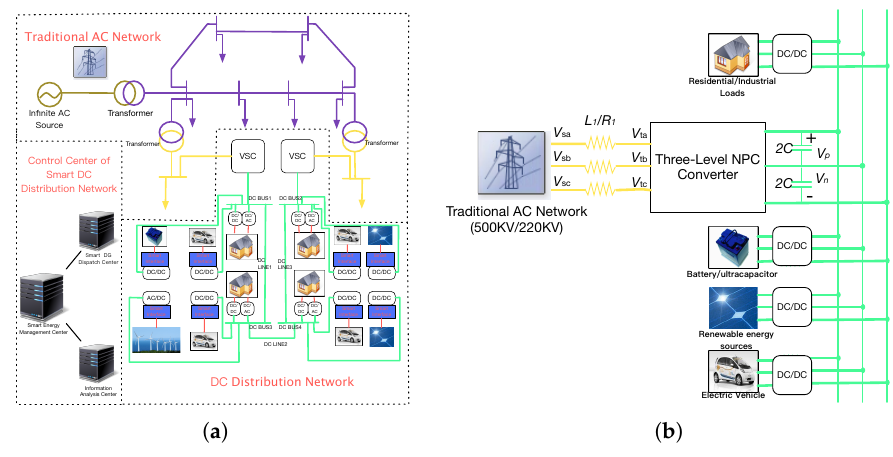
Figure 1. Structure of the DC distribution system. ( a ) proposed DC distribution network; ( b ) simplified DC distribution